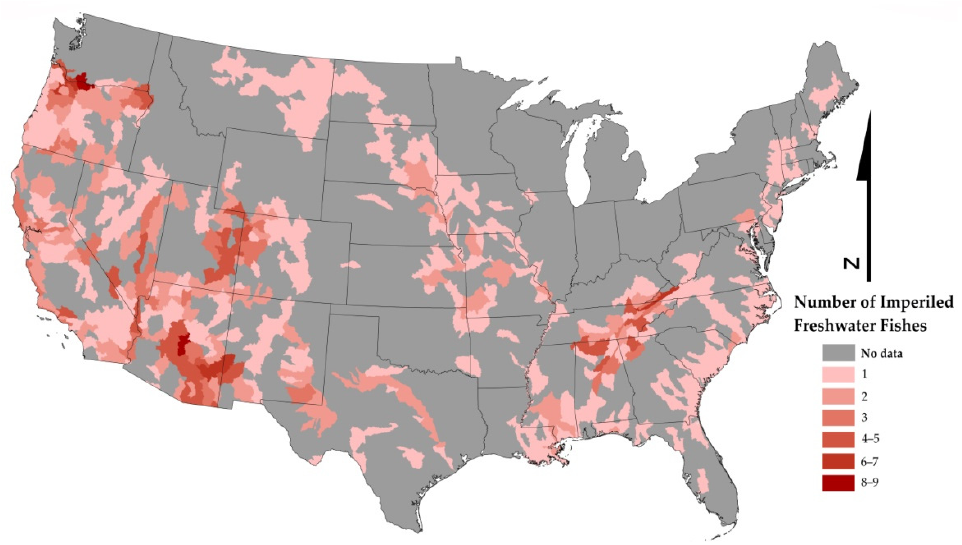
Figure 2. Number of endangered fishes per HUC8 of the conterminous United States, based on the NatureServe dataset. This dataset only includes HUC8s where endangered fish are recorded, and HUC8s with no records of imperiled fish are displayed as “no data”.